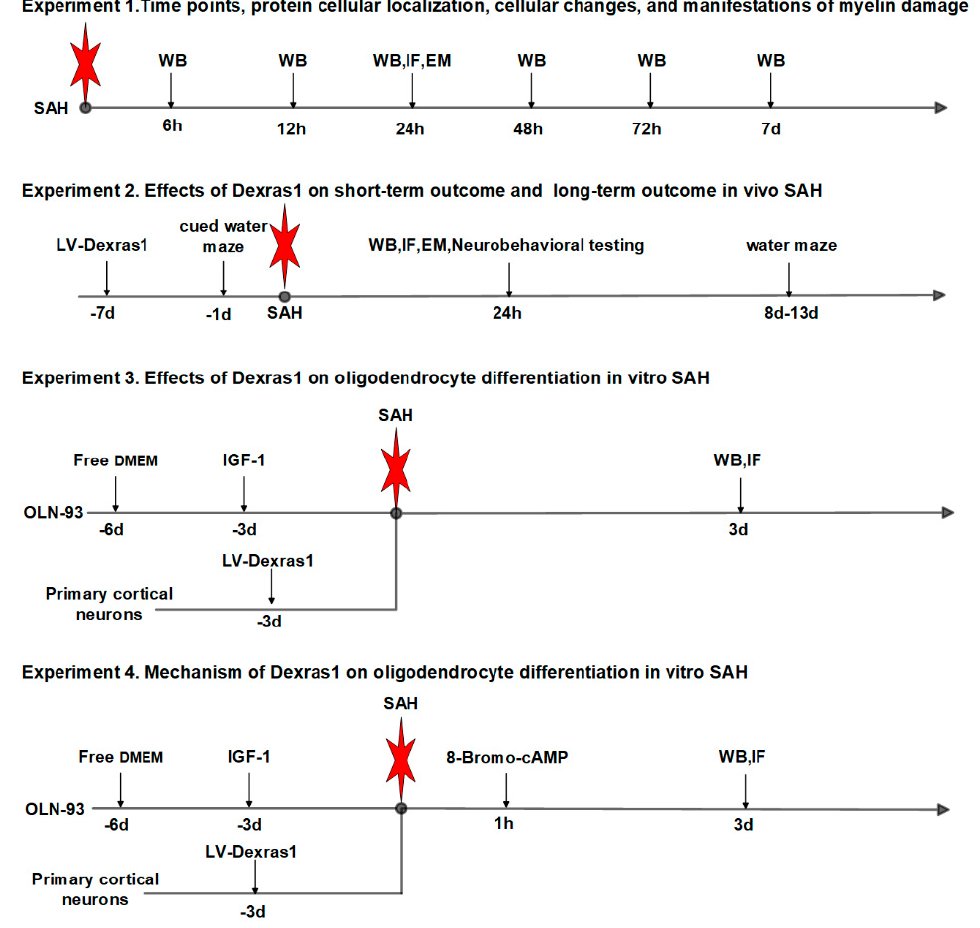
Figure 1. Four separated experiments schematic. Experiment 1: To study the temporal expression and cellular localization of Dexras1, 35 rats were randomly divided and assigned to seven groups: Sham ( n = 5), SAH-6 h ( n = 5), SAH-12 h ( n = 5), SAH-24 h ( n = 5), SAH-48 h ( n = 5), SAH-72 h ( n = 5), SAH-7 d ( n = 5). Western blot analysis was performed to determine the expression changes of Dexras1 and other proteins. An additional 12 rats in the Sham ( n = 3) and SAH-24 h ( n = 3) groups were used for double immunofluorescence staining, electron microscopy. Experiment 2: Seven days after lentivirus injection into the lateral ventricle, to evaluate the effects of Dexras1 on short-term outcome after SAH, 40 rats were randomly divided and assigned to eight groups for Western blot and SAH grade: Sham ( n = 5), SAH+LV-scramble ( n = 5), SAH+LV-Dexras1 + (2 U, n = 5), SAH+LV-Dexras1 + (4 U, n = 5), and SAH+LV-Dexras1 + (6 U, n = 5), SAH +LV-Dexras1 − (2 U, n = 5), SAH +LV-Dexras1 − (4 U, n = 5), SAH +LV-Dexras1 − (6 U, n = 5). Based on the results of Western blot, Sham ( n = 3), SAH+LV-scramble ( n = 3), SAH+LV-Dexras1 + (6 U, n = 3), and LV-Dexras1 − (6 U, n = 3) group rats were used for immunofluorescence staining and electron microscopy to evaluate OPCs differentiation and myelin damage in the ipsilateral hemisphere at 24 h after SAH. To evaluate the effects of Dexras1 on long-term outcome after SAH, Morris water maze of these groups (additional 25 rats, 5 per group) was performed on day 8–13 after SAH. Experiment 3: To explore the effects of Dexras1 on oligodendrocyte differentiation in vitro SAH. Primary cortical neurons transfected with Dexras1 were co-cultured with IGF-I induced differentiated OLN-93 cells. Western blot analysis and immunofluorescence staining was performed to evaluate OPCs differentiation in vitro SAH model. Experiment 4: To explore the mechanism of Dexras1 on oligodendrocyte differentiation in vitro SAH. Primary cortical neurons transfected with Dexras1 were co-cultured with IGF-I-induced differentiated OLN-93 cells, and 8-Bromo-cAMP was added after co-culture for 1 h. Western blot analysis and immunofluorescence staining was performed to evaluate OPCs differentiation in vitro SAH